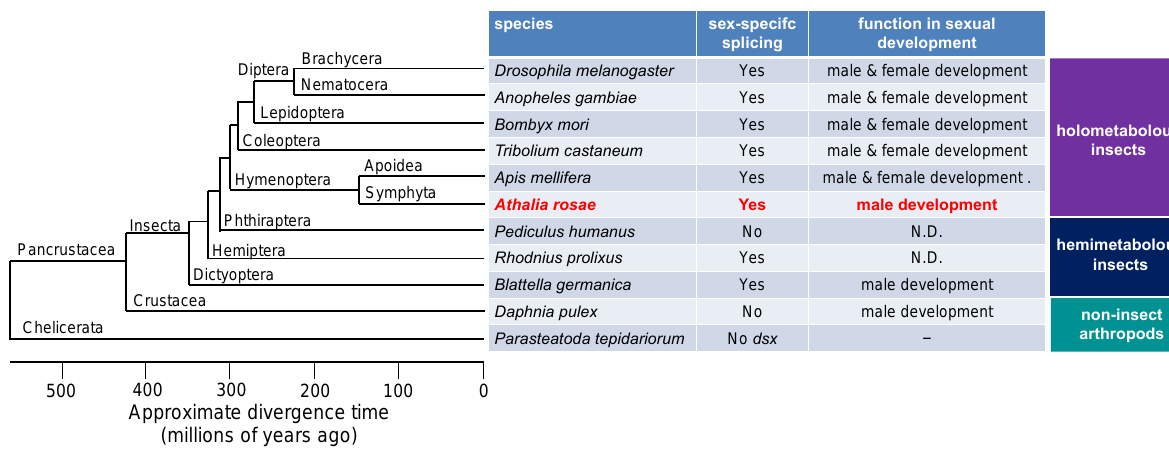
Figure 6. Summary of the status of sex-specific splicing of dsx and its function in sex differentiation in some representative species of insects and non-insect arthropods. The phylogenetic tree was drawn with reference to Figure 1 of a previous study published by the Honeybee Genome Sequencing Consortium (2006) [68]. “Yes” means that dsx pre-mRNA undergoes sex-specific splicing to yield male- and female-specific isoforms. “No” indicates that dsx pre-mRNA is not sex-specifically spliced. “No dsx ” indicates that there is no dsx ortholog in the genome. N.D., not determined.